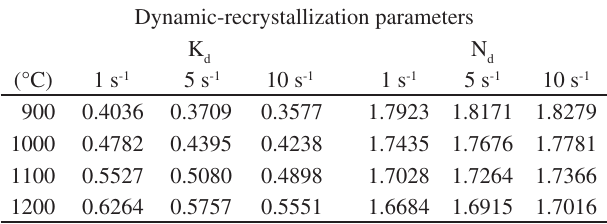
Table 4. Dependence of the Avrami-equation parameters on the deformation conditions.